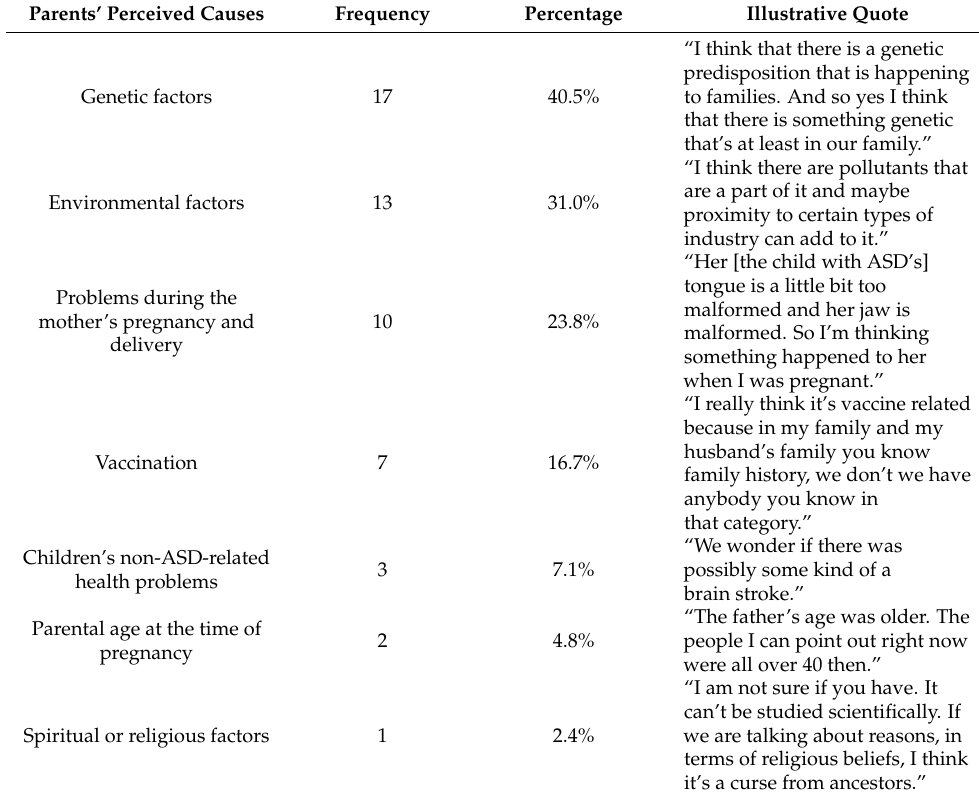
Table 2. Parents’ Perceived Causes of